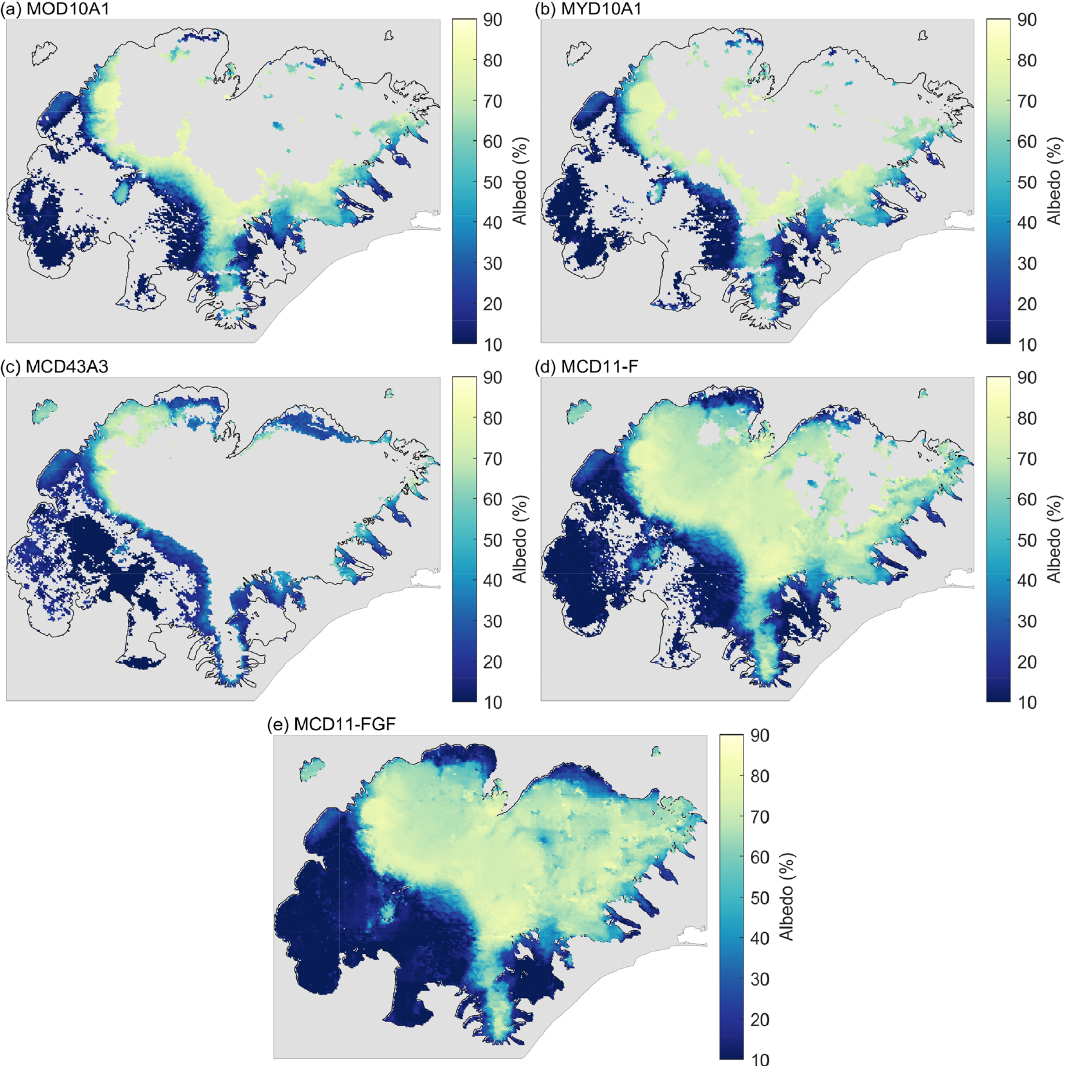
Figure A3. Albedo maps for different processing and products post-eruption at Grímsvötn. Data are shown for 18 June 2011. Panels (a) and (b) show the original albedo tiles ( Snow Albedo Daily Tile ) for the original MODIS products (M ∗ D10A1). Panel (c) shows albedo data for MCD43A3 (Albedo BSA shortwave). Panel (d) shows the MCD11 product (MCD11-F) after median-based outlier removal, and (e) shows the final MCD11 (MCD11-FGF) product after median-based outlier removal and gap filling as described in Sect.